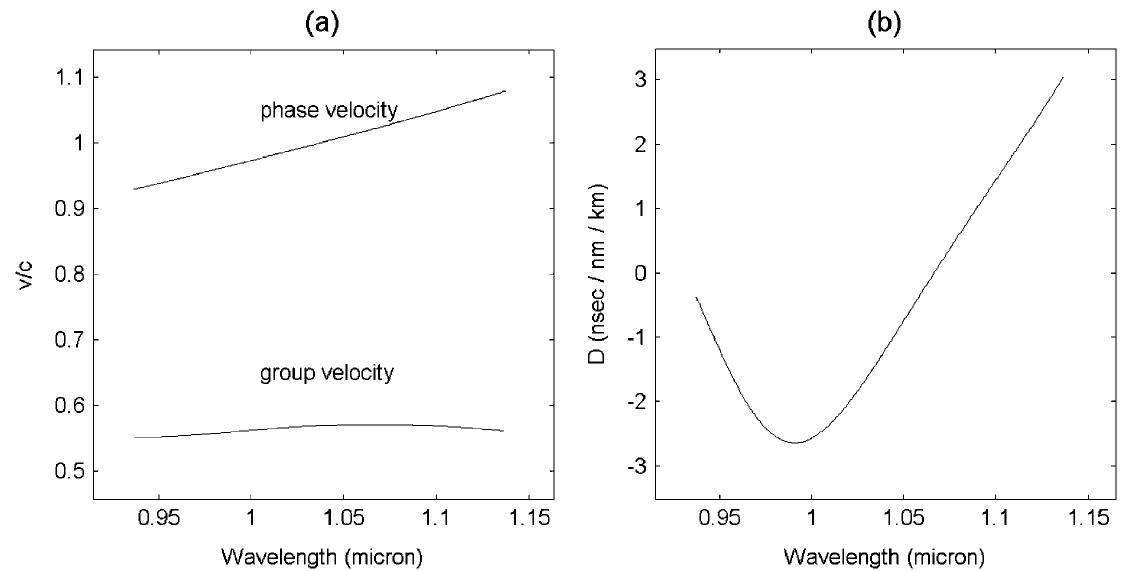
FIG. 14. (a) Phase velocity, group velocity, and (b) dispersion parameter of the TM defect mode as a function of free-space wavelength for the 4 : 9 (cid:3) m -period fiber when scaled to a 1 : 3 (cid:3) m lattice period.